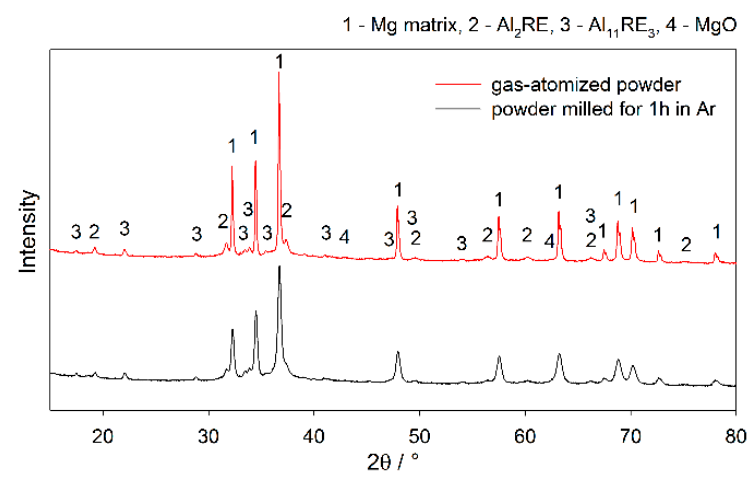
Figure 2. XRD diffraction pattern of the gas-atomized and attritor-milled powder. Figure 2. XRD di ff raction pattern of the gas-atomized and attritor-milled